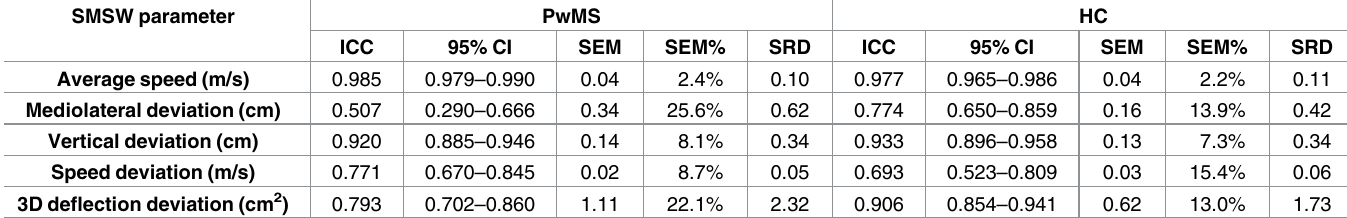
Table 4. Test-retest-reliability and smallest real